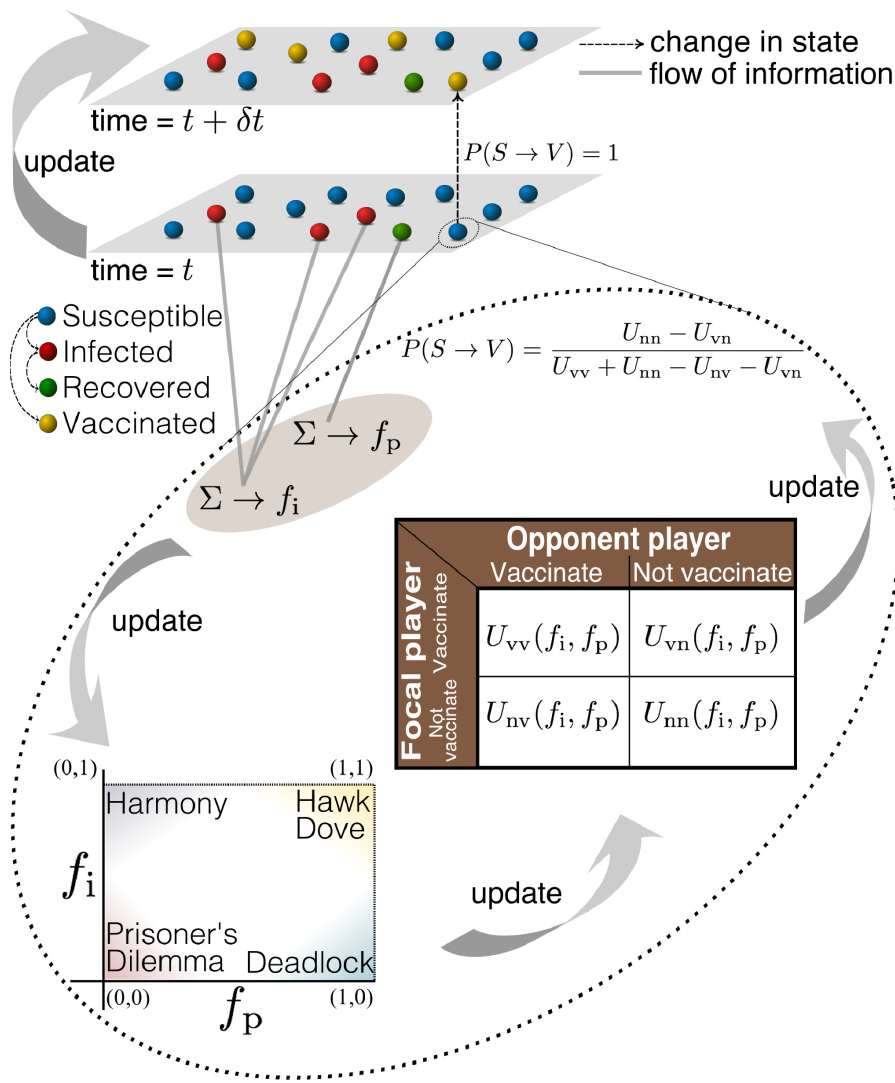
Fig 1. Schematic representation of the coupling between the spread of an epidemic and strategic vaccine uptake behavior by individuals. Agents are classified according to their state with respect the disease as Susceptible (S), Infected (I), Recovered (R) and Vaccinated (V). The two layers represent the states of the nodes at two time instants. The broken lines represent the change in the state of agents and grey solid lines represent the flow of information about the state (infected and removed) of agents in the network. The curved arrow between the two layers represents the update (time evolution) of the system. The broken curve encloses the game-theoretic process that determines whether an agent decides to vaccinate or not, based on the probability of an agent choosing to get vaccinated P ( S ! V ). The table inside the broken curve is a payoff matrix used by an agent to make decisions. Here the “opponent” is a hypothetical agent having identical information, choices of actions and associated payoffs. The payoff received by the focal player is represented by a function of the form U xy ( f i , f p ), where x and y are the actions of the focal player and opponent respectively. The fractions of infected and protected (immune) agents are represented by f i and f p , respectively. By varying these two parameters the nature of the game can change between different classes, as shown in the inset to the lower